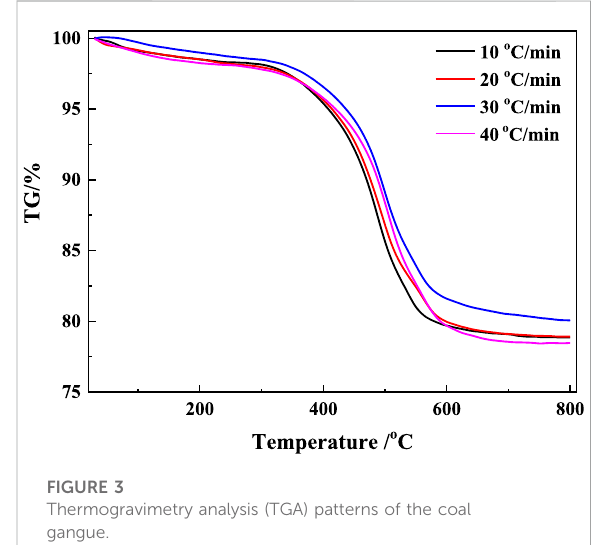
FIGURE 4 Differential thermogravimetry (DTG) mapping of the coal